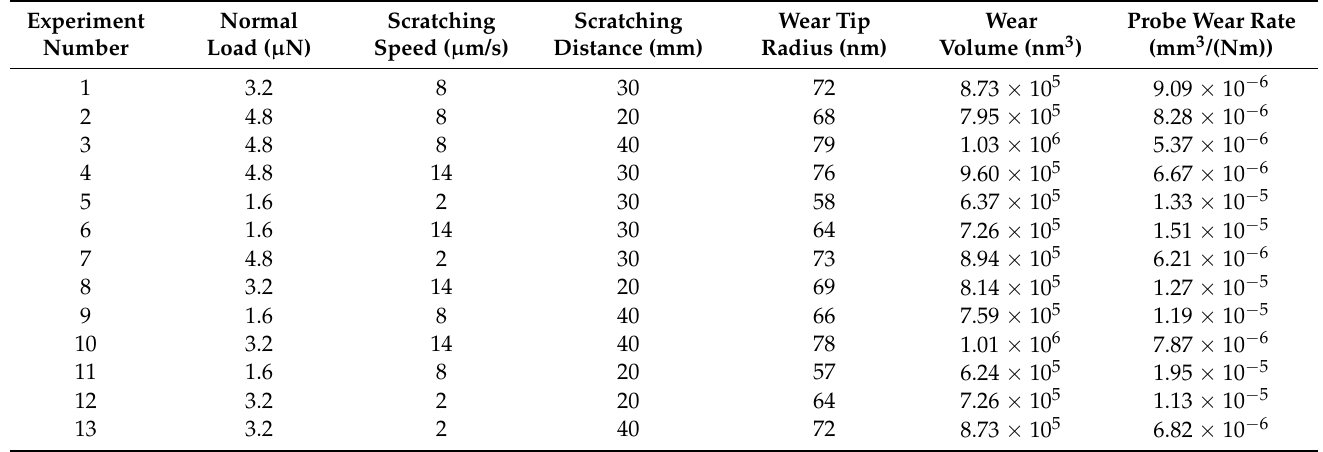
Table 3. Response surface experiment scheme and